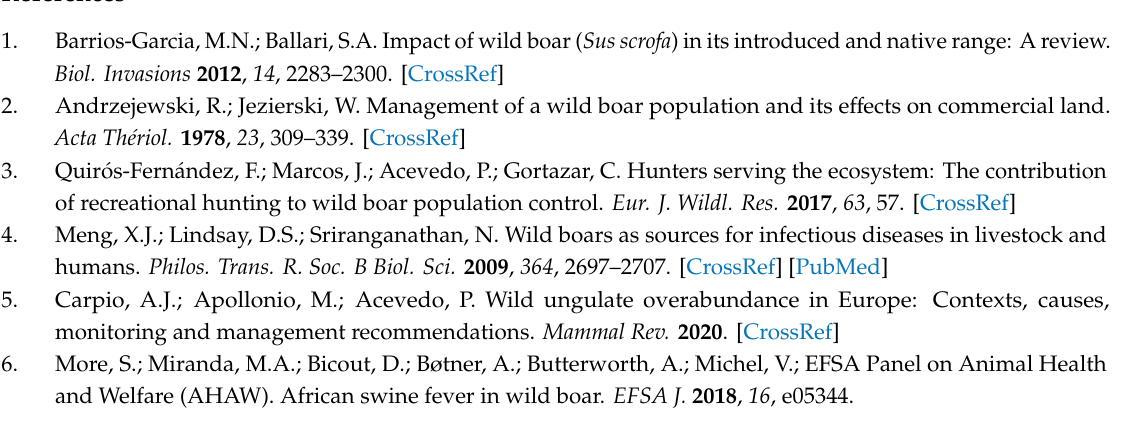
Table S1: Number of culled wild boar ( Sus scrofa ) in the period 1965–2016 in the Czempi´n hunting area in western Poland. The groups (Females vs Males and Individual vs Team hunt type) are compared by post-hoc according to fitted Poisson model with interaction sex × age × method. Comparison and p values were adjusted by Sidak’s